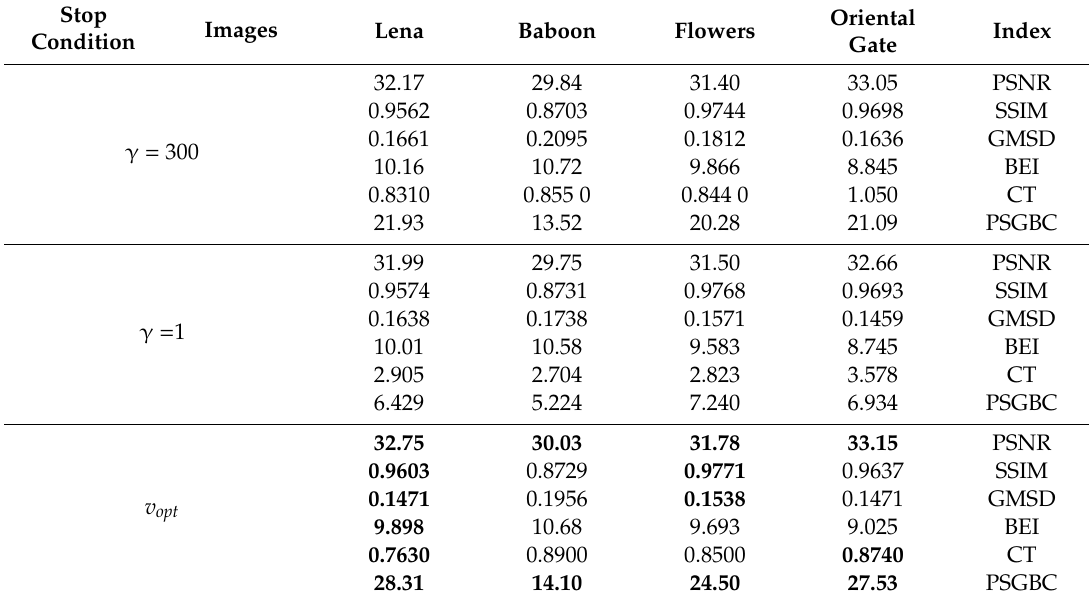
Table 4. The performance indexes of test images under di ff erent iterative stop condition. IndexStop Images Lena Baboon Flowers